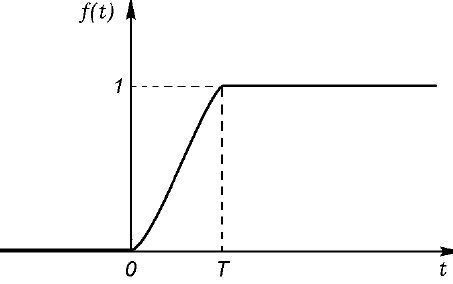
Figure 1: Schematic of fracture kinetics at the place of